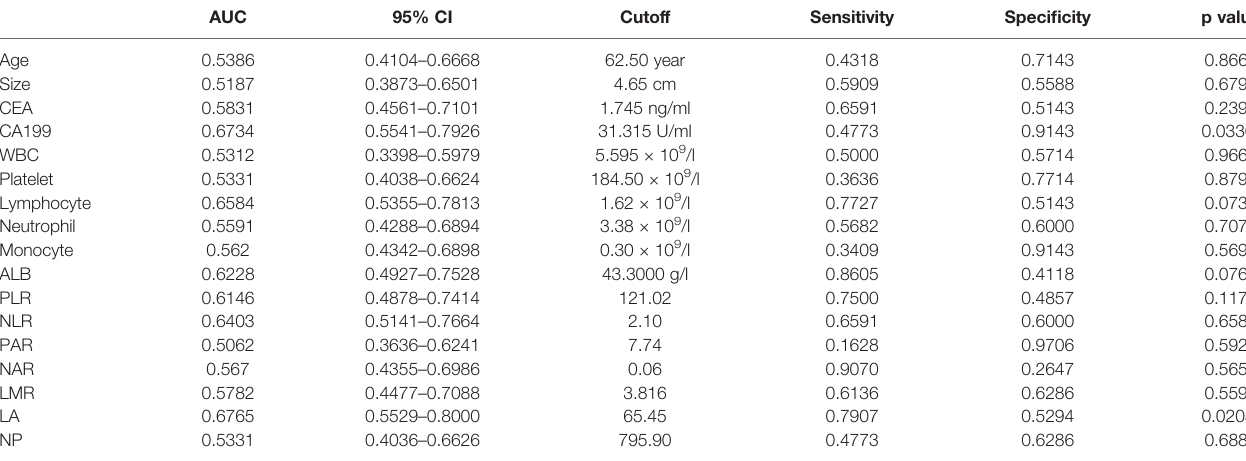
TABLE 4 | Diagnostic ef fi cacy of the indices in differentiating SCNs and MCNs. AUC 95% CI Cutoff Sensitivity Speci fi